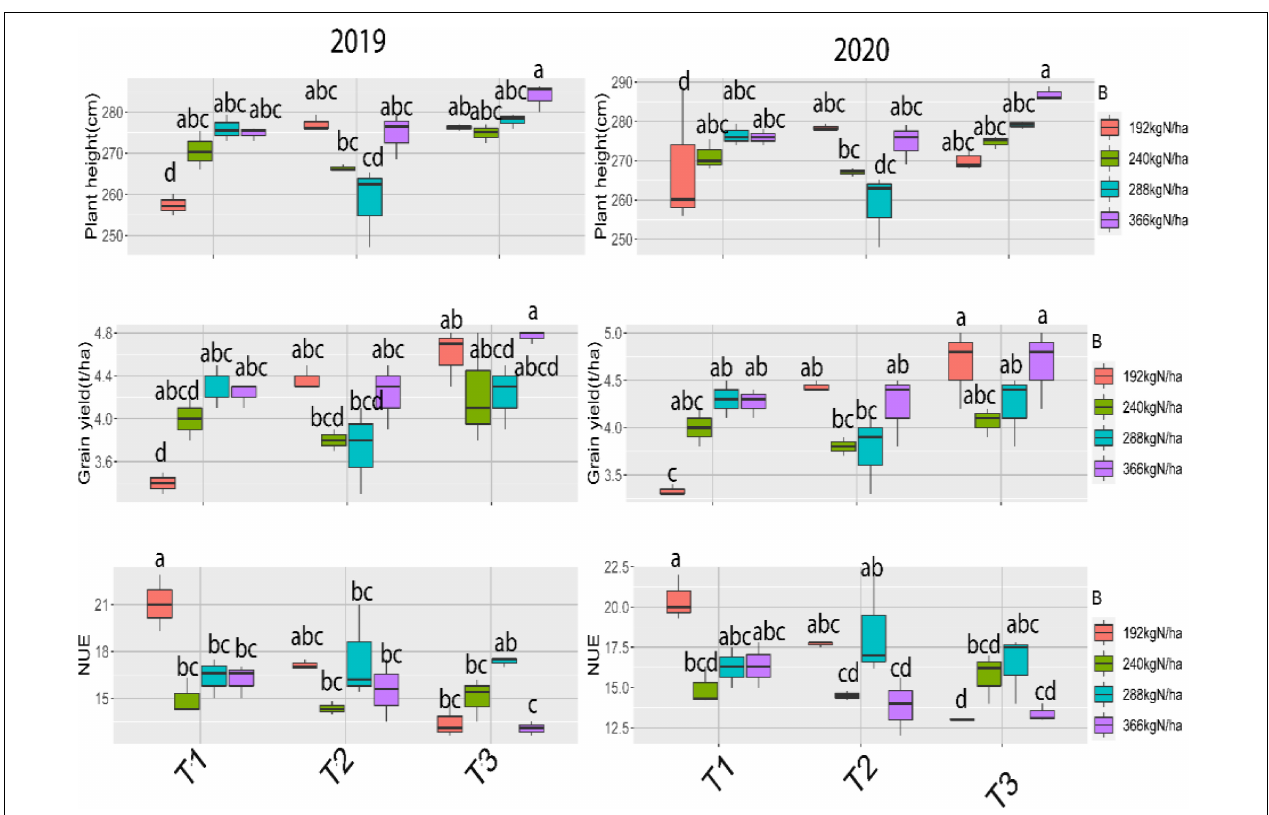
FIGURE 1 | Effects of interaction between nitrogen rates and application time on maize growth parameters across two seasons (2019 and 2020), where T 1 (50% of N at each of sowing and 1st irrigation), T 2 (50% of N at each of sowing and 2nd irrigation) and T 3 (50% of N at each of 1st and 2nd irrigation).